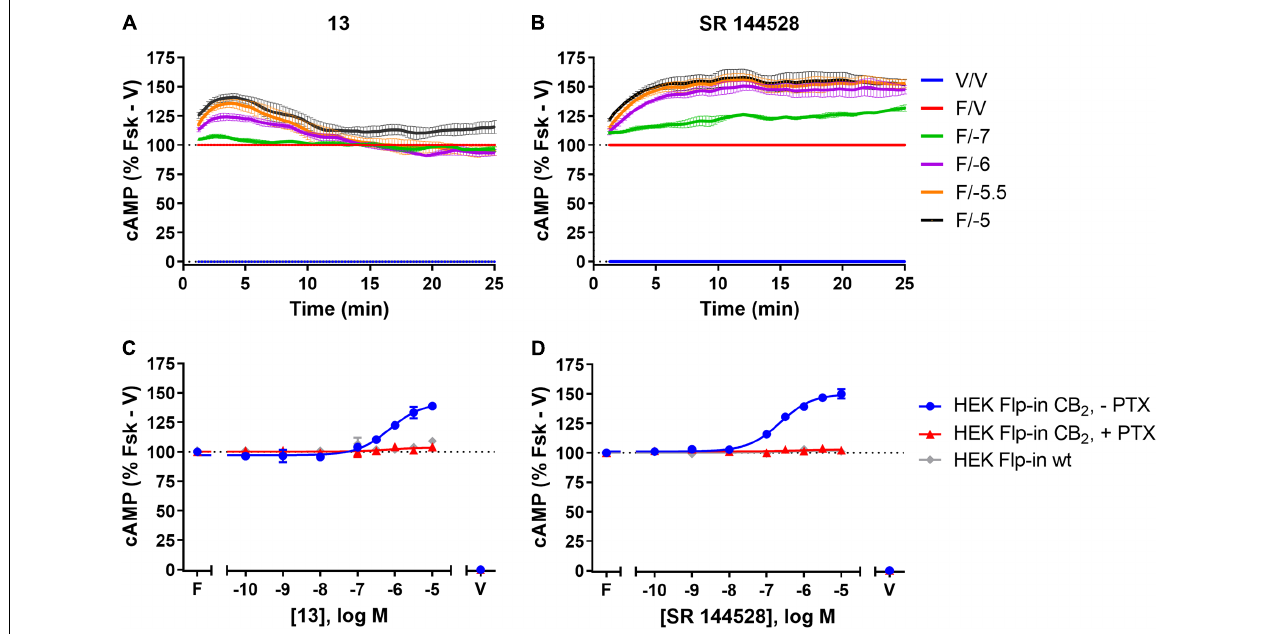
FIGURE 3 | cAMP signalling in HEK Flp-in hCB 2 and HEK Flp-in wt cells in response to 13 and prototypic inverse agonist, SR 144528. (A,B) Time courses for modulation of cAMP concentration by 13 (A) and SR 144528 (B) at active concentrations (noted in log units, in the presence of 5 µ M forskolin “F/_”) on HEK Flp-in hCB 2 cells. Data were normalised to vehicle-treated (“V/V”; 0%) and forskolin alone (“F/V”; 100%). (C,D) Concentration-response curves for modulation of cAMP concentration by compound 13 (C) and SR 144528 (D) (both in the presence of 5 µ M forskolin) in HEK Flp-in hCB 2 cells following 16–20 h pre-treatment in the absence or presence of PTX, or in HEK Flp-in wt cells. Concentration-response curves were generated by plotting each concentration measured at 5 min post-drug addition. These data were then normalised to vehicle-treated (V; 0%) and forskolin alone (F, Fsk; 100%). Data in all panels are presented as mean ± SEM from three independent